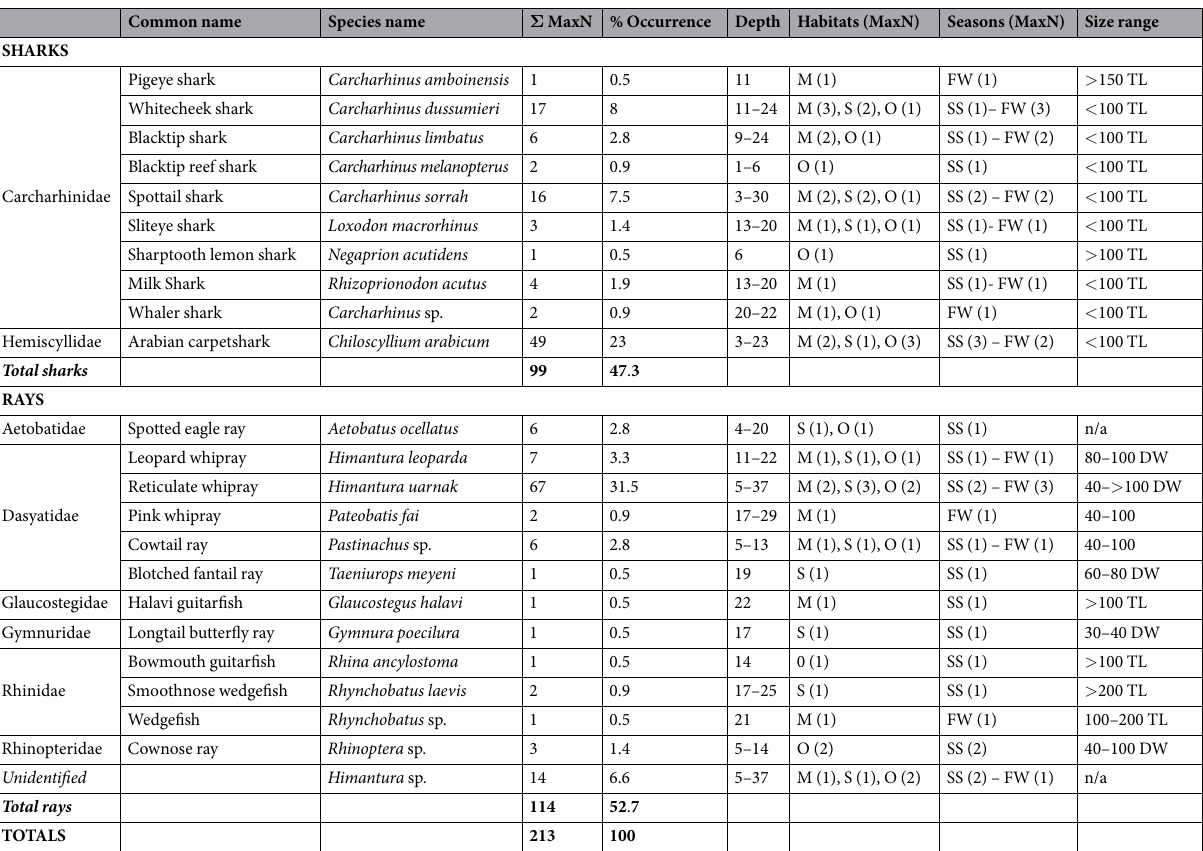
Table 2. Summary of results of Baited Remote Underwater Video Surveys (BRUVS) with a summary of shark and ray species observed during deployments, abundance (sum ( Σ ) of MaxN and % MaxN), depth ranges (m), habitat associations (S – Sand, M – Mud, O – Other; and MaxN by type), seasons (SS – Spring/Summer, FW – Fall/Winter; and MaxN for each), and estimated size ranges (cm) as total length (TL) or Disc Width (DW). n/a indicates individuals did not approach the bait arm to allow for size